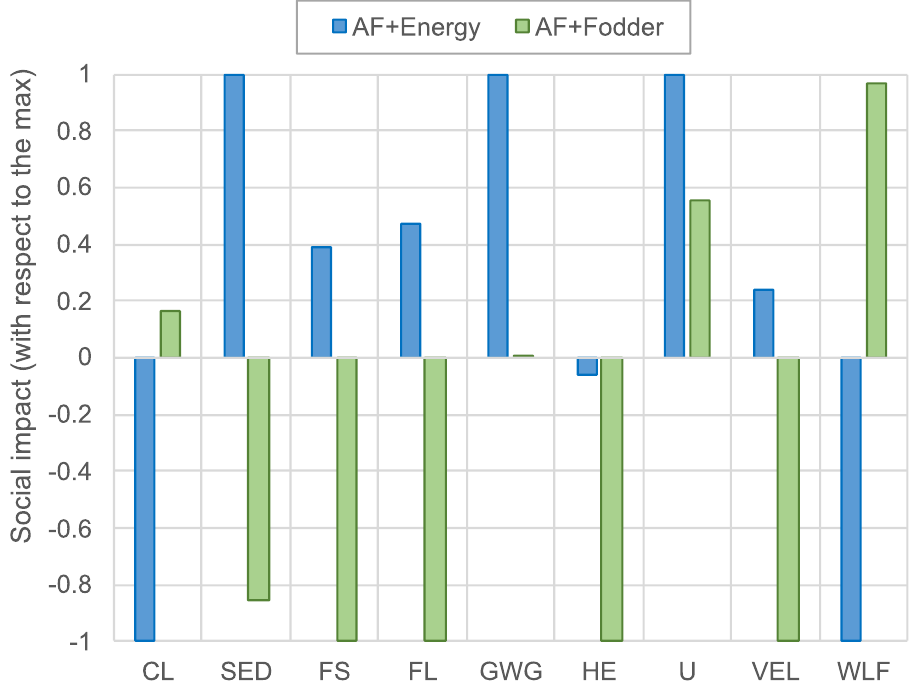
Figure 4. Social life cycle impacts of the AF + energy and AF + fodder systems. Scores are normalized by the highest absolute score in each impact category. Abbreviations: CL—Child Labor; SED—Sector contribution to Economic Development; FS—Fair Salary; FL—frequency of Forced Labor; GWG— Gender Wage Gap; HE—Health Expenditure; U—Unemployment; VEL—Violations of Employment Laws and regulations; WLF—Women in the sectoral Labor Force. Note that SED is the only positive indicator (higher is better), and all other indicators should be interpreted as “lower is